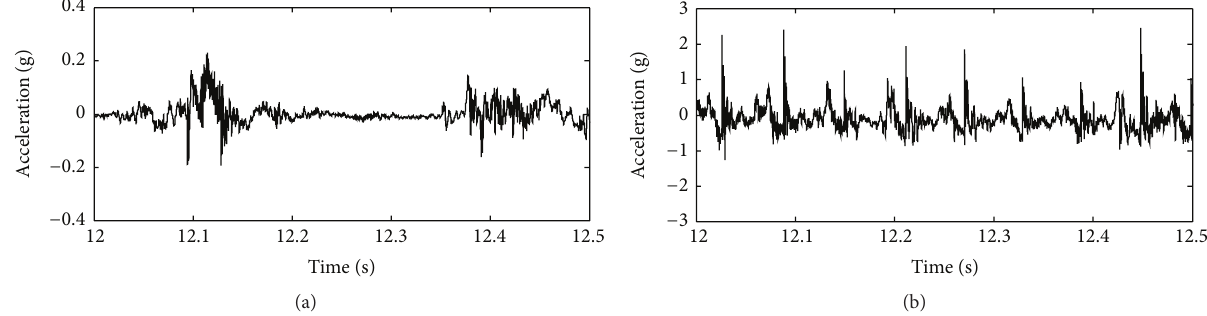
Figure 3: Vertical accelerations of the vehicle with built-in mecanum wheels (a) at low speed and (b) at high speed.